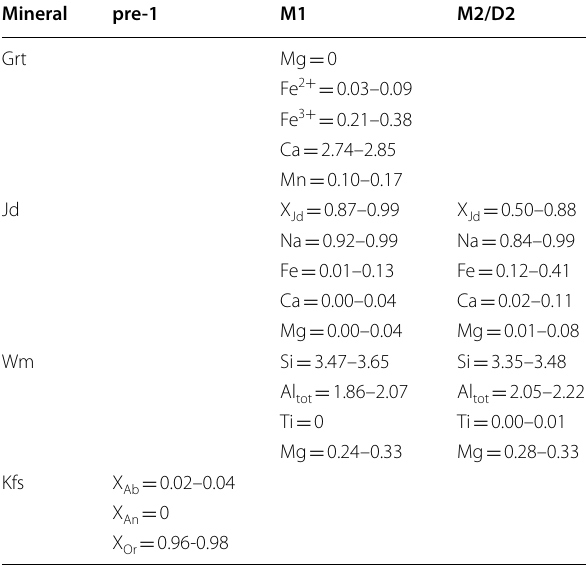
Table 4 Intervals of compositional variations in minerals marking different metamorphic stages of